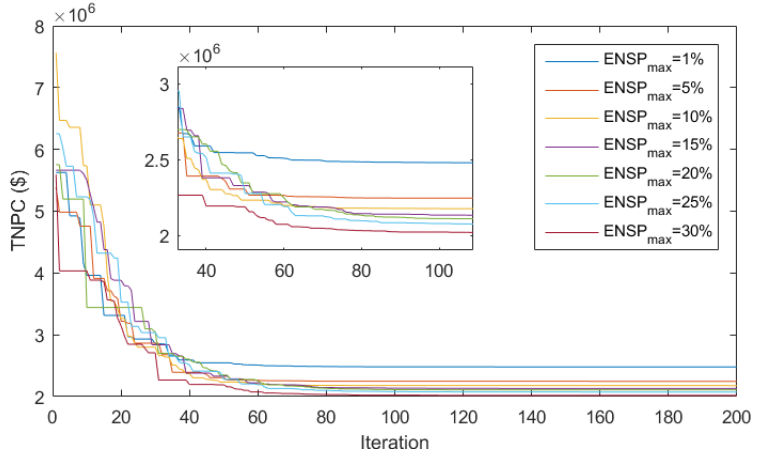
Figure 18. Convergence process of the IAEO in the sizing of HPV/FC energy systems, considering different ENSP max . Table 8. Sizing results of HPV/FC energy systems using the IAEO, considering different ENSP max . ENSP max /Item